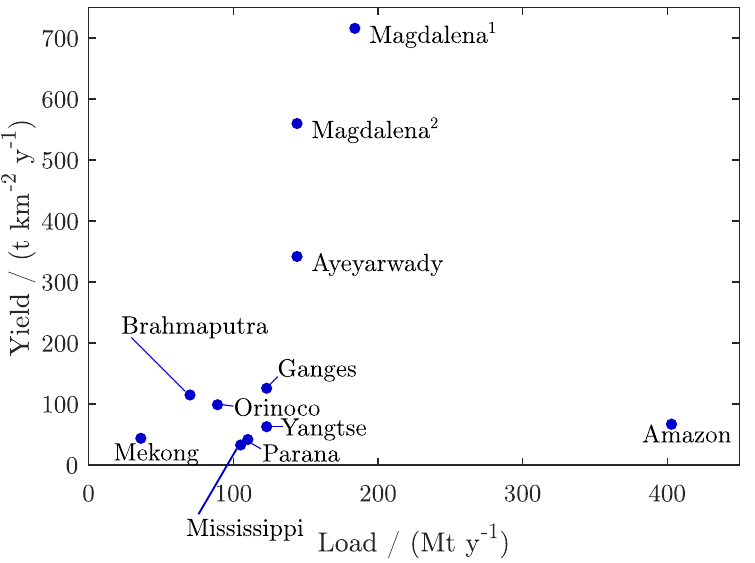
Fig 11. Current annual washload and corrected values of washload as subtracted from the total suspended load of the world’s largest rivers delivering suspended sediments to the Oceans (data and explanations in Table 1).